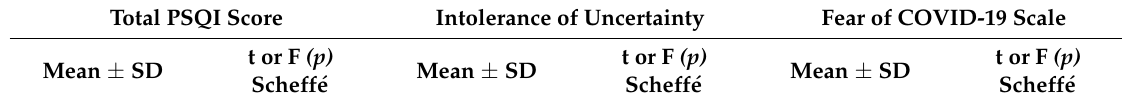
Table 3. Difference in PSQI, Intolerance of Uncertainty, and Fear of COVID-19 according to General Characteristics ( N = 310).